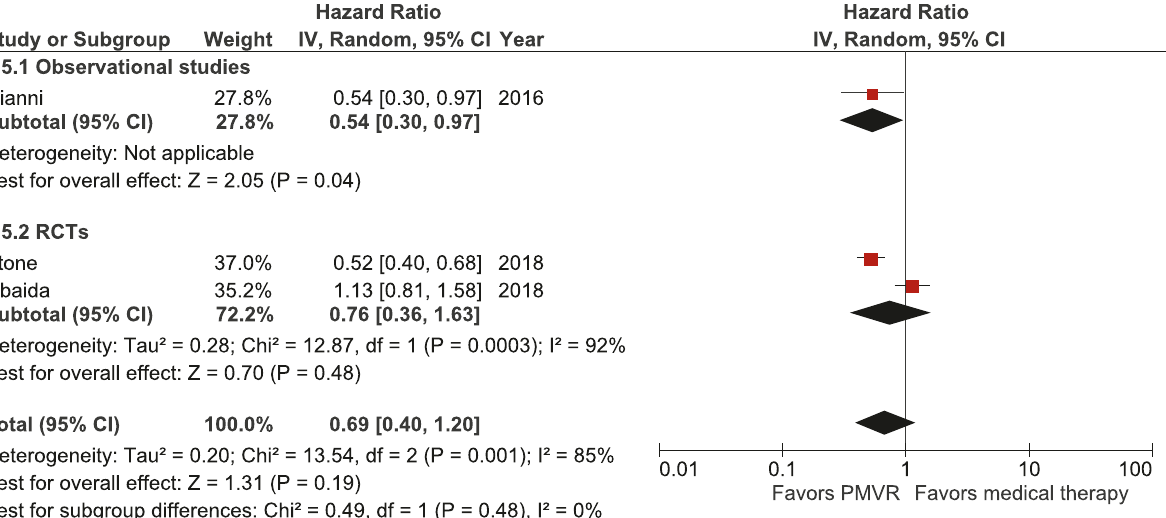
Figure 6: Forest plot displaying the incidence of heart failure hospitalization in the PMVR group compared to the OMT group.